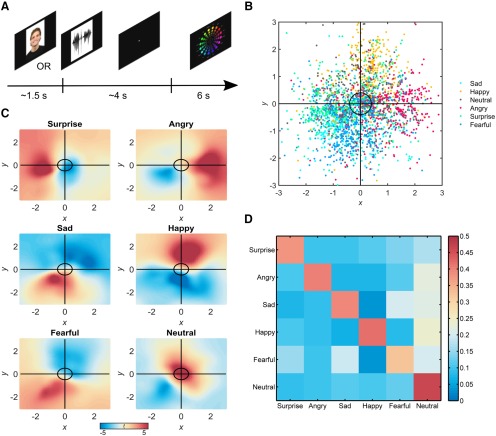
Experimental paradigm and behavioral results. A, Graphical depiction of a single trial in which participants are first presented a facial or vocal expression of emotion, followed by a fixation cross, and a response screen, which subjects used to indicate their own emotional experience in response to the stimuli by moving a cursor. B, Scatterplot of behavioral responses for all participants, with each point corresponding to a single trial. Axes reflect cursor positions along horizontal and vertical dimensions of the screen, standardized within subjects. C, Parametric maps (one sample t test, n = 21) of support vector machine decision values for each emotion category, showing which coordinates lead to the prediction of each emotion. Cursors located in blue regions are evidence against the labeled category, whereas red regions indicate positively predictive regions. D, Confusion matrix for classification of self-report. Color bar indicates proportion of trials (chance = 16.67%) from each emotion category (rows) assigned each label during classification (columns).